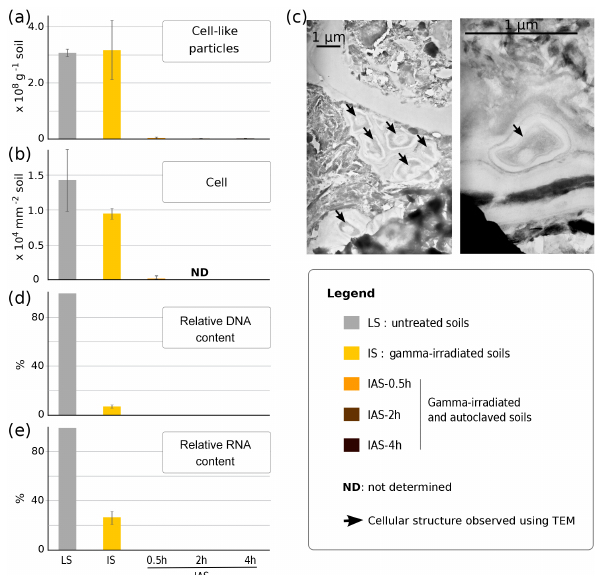
Figure 2. Impact of sterilization treatments on cellular density, in- tegrity, and functionality. (a) Cell density enumerated by flow cy- tometry (FC), (b) cell density and integrity determined by transmis- sion electron microscopy (TEM), (c) TEM photographs of ultrathin sections of soil showing cellular structure in LS, (d) relative DNA and (e) relative RNA content in soils (dry mass basis) in percentages estimated using LS as a reference. Values succeeding IAS refer to the duration of autoclaving. Standard deviation was estimated using three replicates per condition ( n = 3).